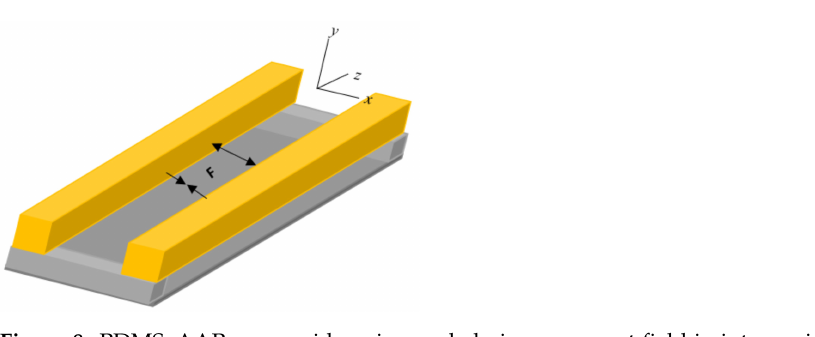
Figure 8. PDMS–AAP waveguide pair coupled via evanescent field in intervening space. Arrow heads’ directions indicate attractive and repulsive forces of even and odd parity